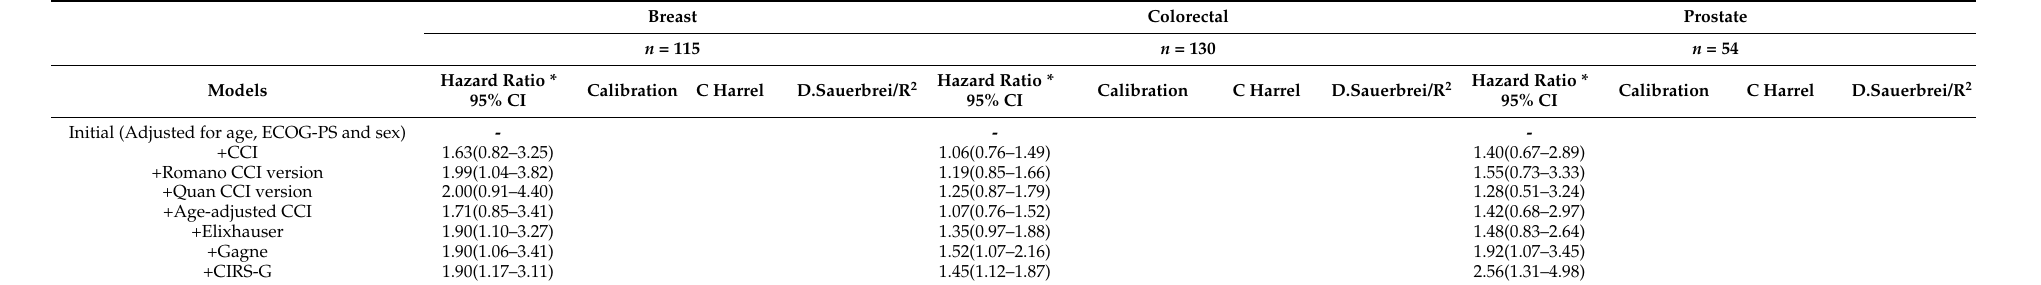
Table 5. The association of each comorbidity index with one-year mortality by cancer group after the imputation of missing data.